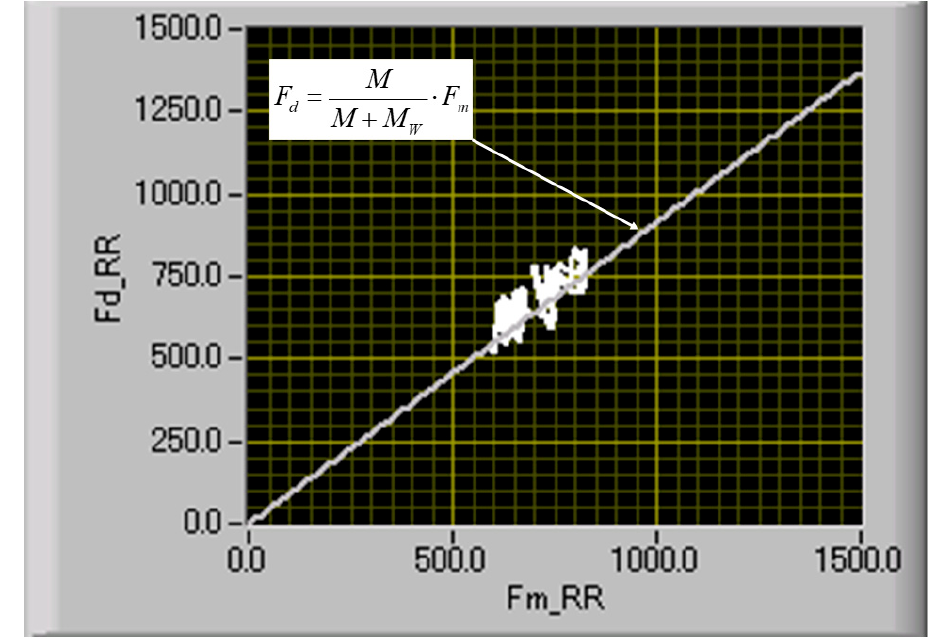
Figure 6. Relationship between the friction force, F d_RR , and the motor torque, F m_RR , at steady state in the accelerated turning test.